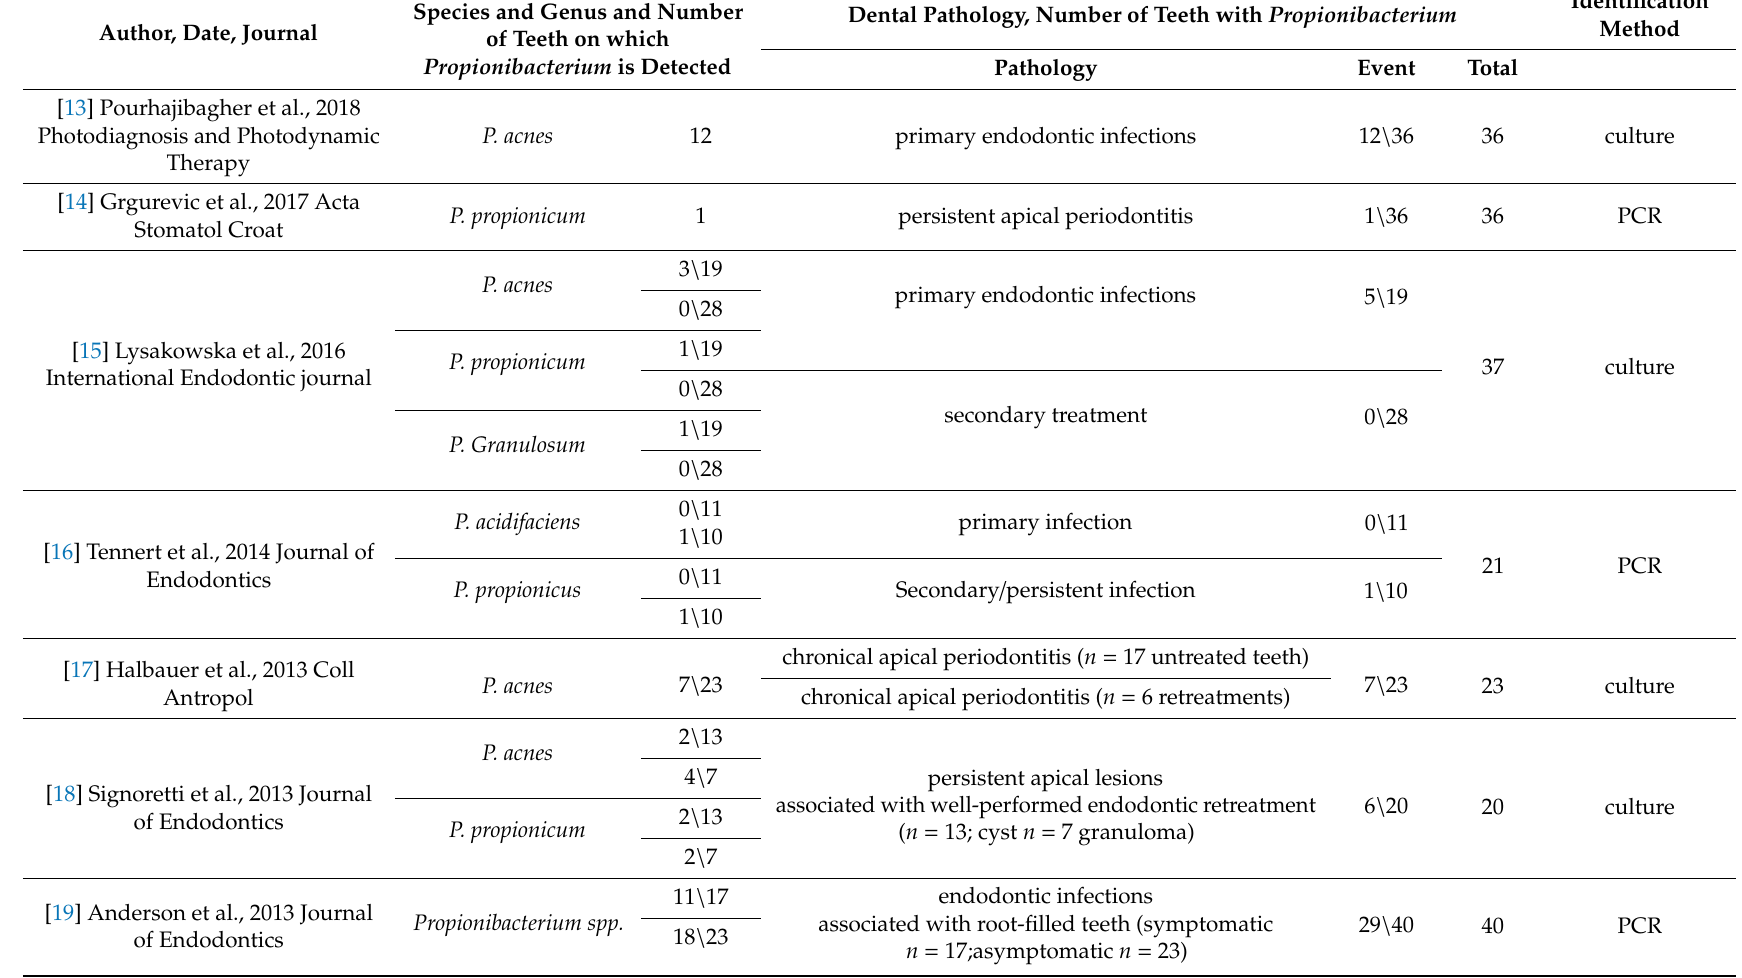
Table 3. Primary outcome (the data regarding the prevalence of bacteria of the genus Propionibacterium in the various studies are